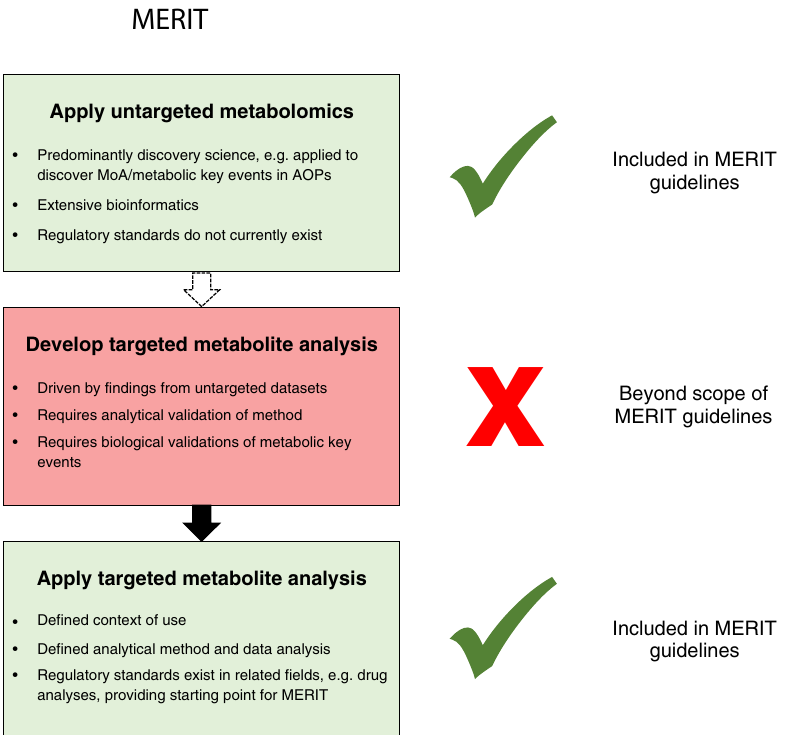
Fig. 1 Types of metabolite analyses in regulatory toxicology and scope of the MERIT project. Dotted arrow indicates potential translation of knowledge from untargeted to targeted assays, although targeted assays can be developed and applied without an initial metabolomics study